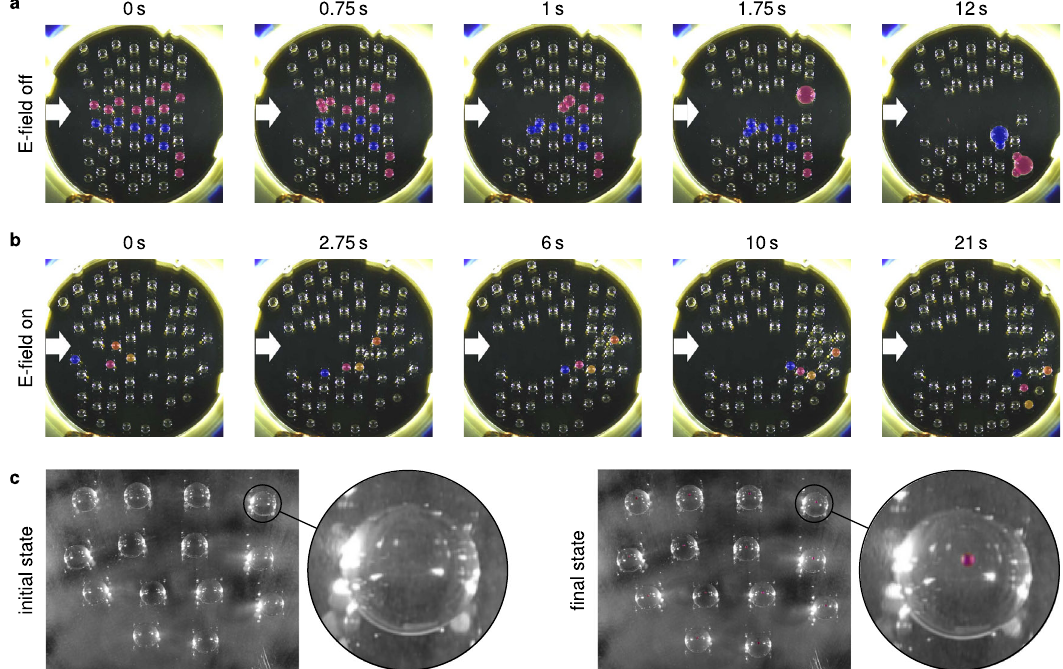
Fig. 5 Multi-droplet dynamics: Coalescence suppression and sample withdrawal. Multi-droplet dynamics in the parallel-plate capacitor induced by lateral air fl ow for a zero electric fi eld and b an applied voltage of 5.5 kV with an air gap width of 3.5 mm. Colors were assigned to speci fi c droplets by image post- processing. Droplets of the same color coalesce during the time interval covered by the image sequence. In part b , the coloring of droplets serves to track selected droplets. The white arrows indicate the direction of the lateral air fl ow and the position at which the air fl ow is applied. The time stamps of the frames indicate the time relative to the fi rst frame of each sequence. c Parallel sampling from an array of droplets. The image on the left (right) side shows the array of 30 μ L droplets before (after) the electric fi eld strength was increased above the critical value. When the images were recorded, no fi eld was applied. Small pendant droplets at the upper glass surface are visible in magenta. For better visibility the images were converted to grayscale format except for the small droplets. The magni fi ed views show one speci fi c